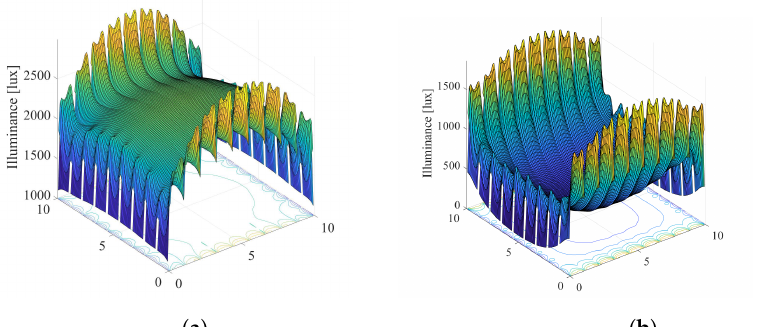
Figure 7. Overall illumination when s i = 1 ∀ i , Φ 1/2 = 60 0 . ( a ) Joint illumination for k = 0 and k = 1. ( b ) Illumination only for k = 1.